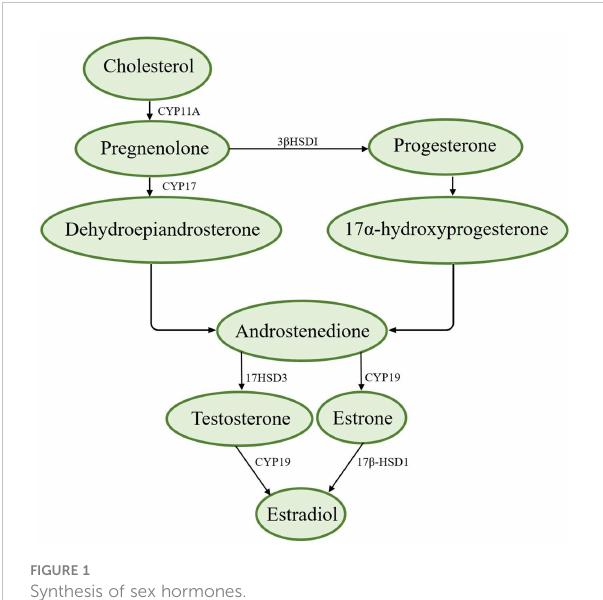
FIGURE 1 Synthesis of sex